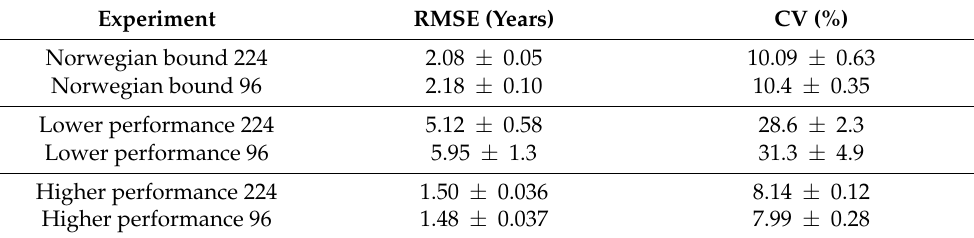
Table 2. Summary of the performances achieved on the experiments that are not considered as domain adaptation, i.e., Norwegian bound and lower/higher performance bounds. For each experiment, the ResNet18 model was trained 5 times (using 5 different random number generators) and we reported the averaged RMSE/CV together with standard deviation over the 5 trials (quantity after ± sign).